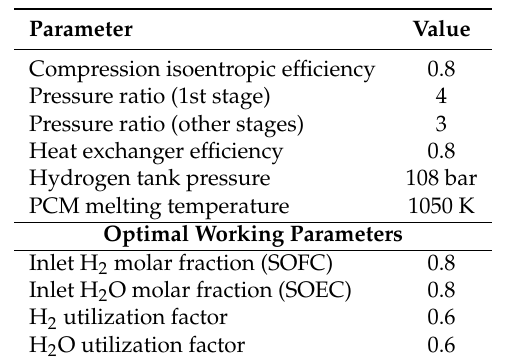
Table 1. Parameters used for the condensed vapor configuration. PCM: phase change